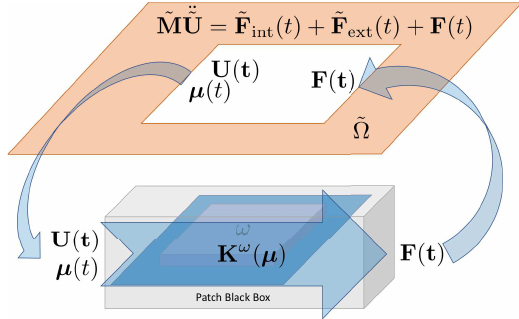
Fig. 4. Time integrator making use of the learned patch